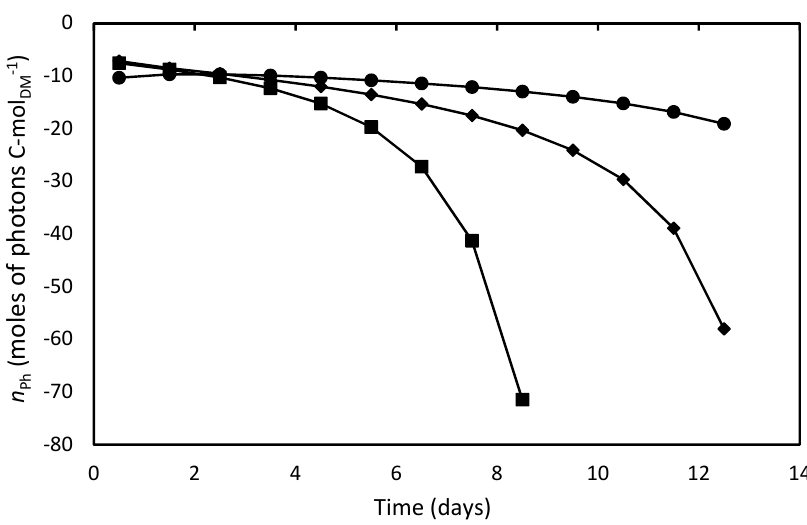
Figure 4. Moles of photons utilized to produce one C-mol biomass of D. tertiolecta in different culture media. F / 2 medium ( (cid:4) ), Bold’s Basal medium ( • ), Alternative medium ( (cid:117) ).